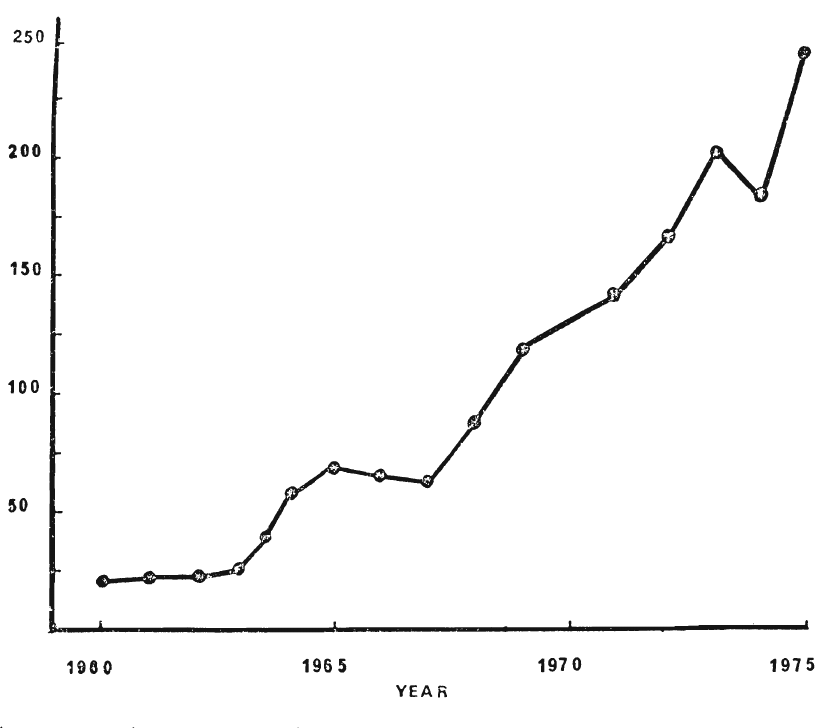
Fig. 3. Population history of springbok Antidorcas marsupialis in the Bontebok National Park,